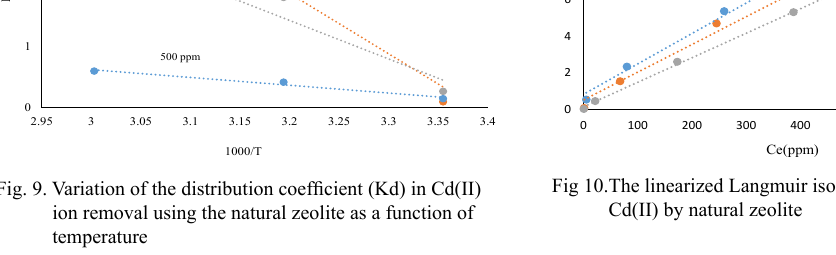
y = 0.0152x + 0.5278 R² = 0.9886